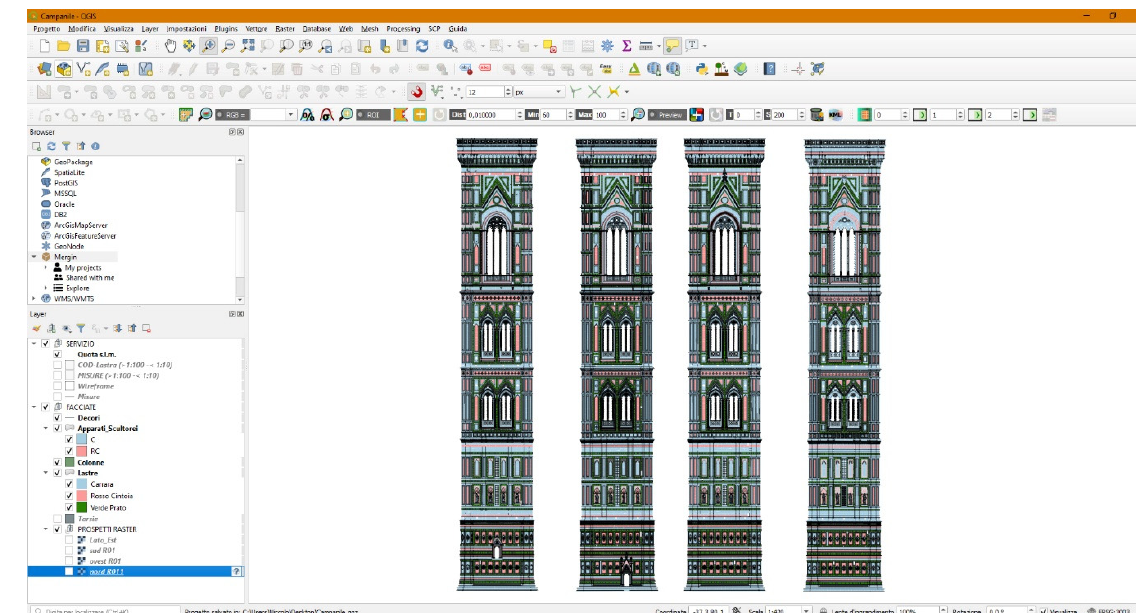
Figure 3. QGIS's project of Giotto’s Campanile. Figure 3. QGIS’s project of Giotto’s Campanile.